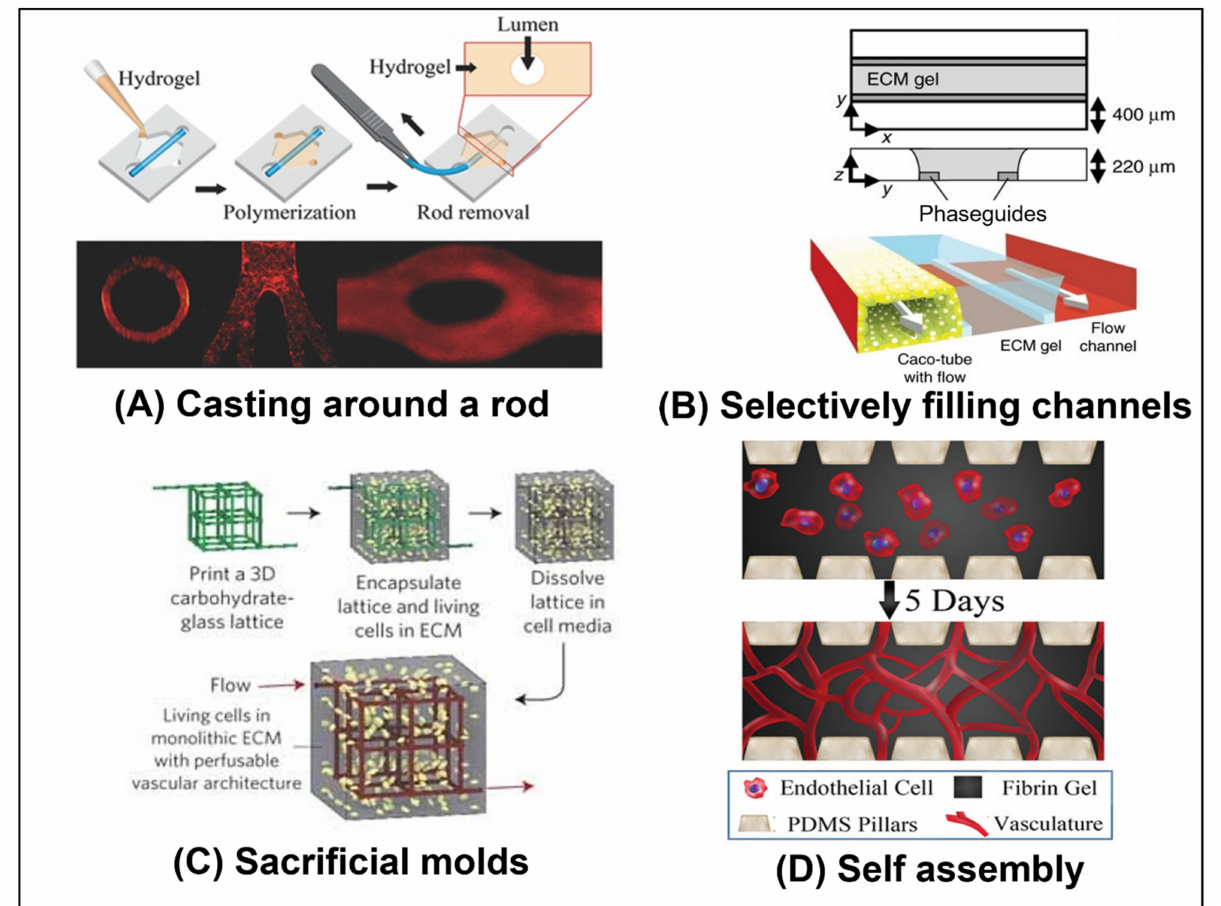
Figure 2. Methods to create tubular structures in organ-on-a-chip models: ( A ) A gel in a liquid state is cast around a flexible PDMS rod. Once the gel solidifies, the rod is removed, leaving a tubular hollow in the gel. As an example, the resulting channels were lined with human umbilical vein endothelial cells (HUVEC) [27]. Reproduced with permission from Advanced Healthcare Materials; published by Wiley, 2018. ( B ) Phaseguides (a short protrusion spanning the length of the channel)